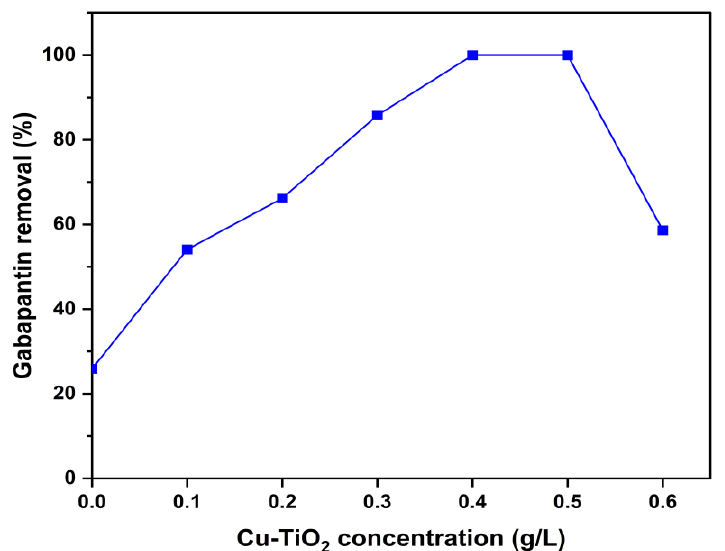
Figure 7. Effect of catalyst concentration on GBP degradation in the Cu-TiO 2 -UVA system (GBP = 10 mg/L, pH = 8, reaction time = 20